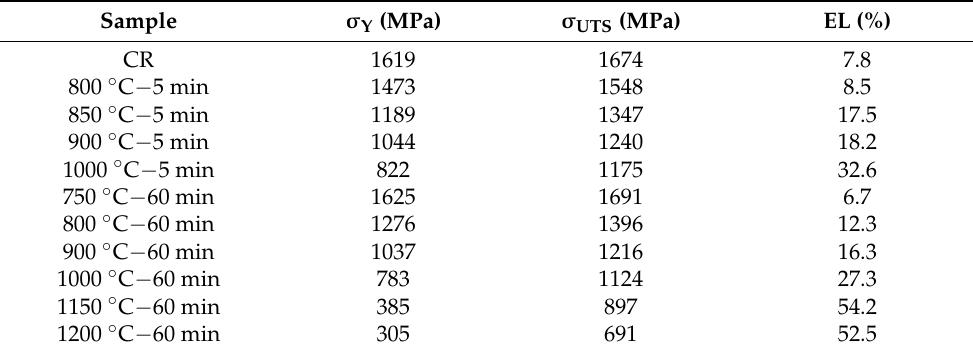
Figure 5. The mechanical properties testing and fracture morphology characterization of the Mo 10 HEA. ( a ) Representative room temperature engineering stress–strain curves of the Mo 10 HEA; ( b 1 , b 2 ) fracture morphology of the 1000 °C − annealed sample. Table 2. The mechanical properties after various heat treatments in the Mo 10 HEA.